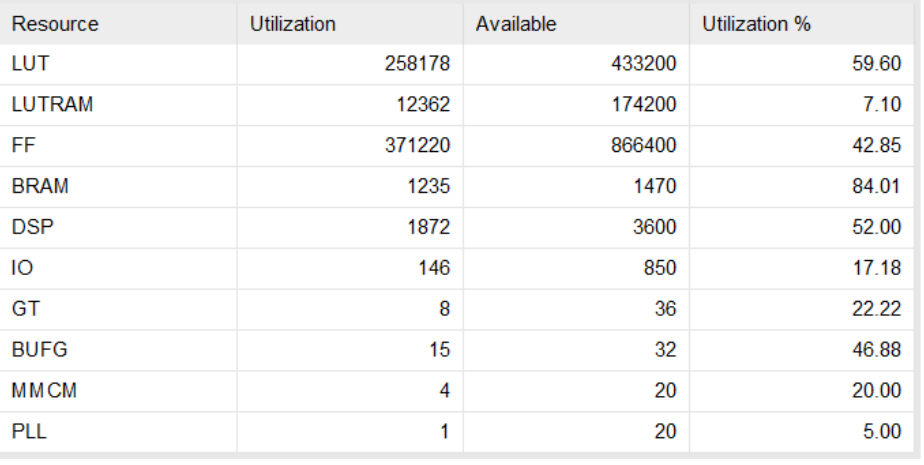
Figure 15. BP algorithm resource analysis.